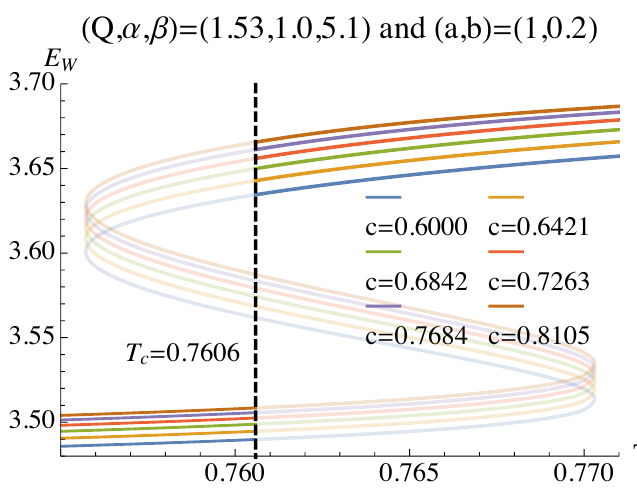
Figure 12 . The T vs. EWCS in presence of the first-order phase transition, where the lighter segments correspond to the metastable regions. The red dashed horizontal line represents the critical temperature T c = 0 . 7547 of the first-order phase transition.